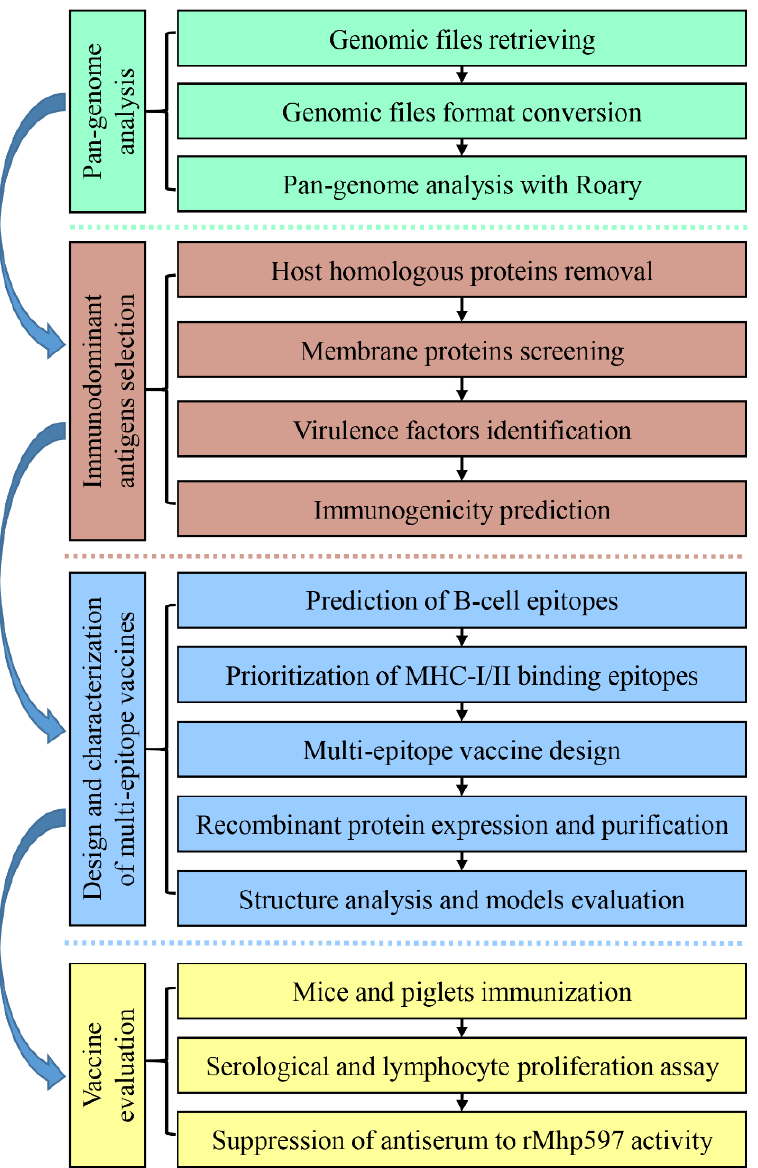
Figure 1. Pipelines for reverse vaccinology and animal immune experiments in this study. Pan-genome analysis was used first to identify the conservative core proteins. Immunodominant antigens were selected by host homologous protein removal, membrane protein selection, and virulence factor database alignment. MHC-I/II binding epitopes were screened by different web services and finally integrated to produce the artificial proteins MhpMEV and MhpMEVC6His. The immunogenicity of MhpMEV was evaluated in animal experiments, and MhpMEVC6His was used for structure analysis.